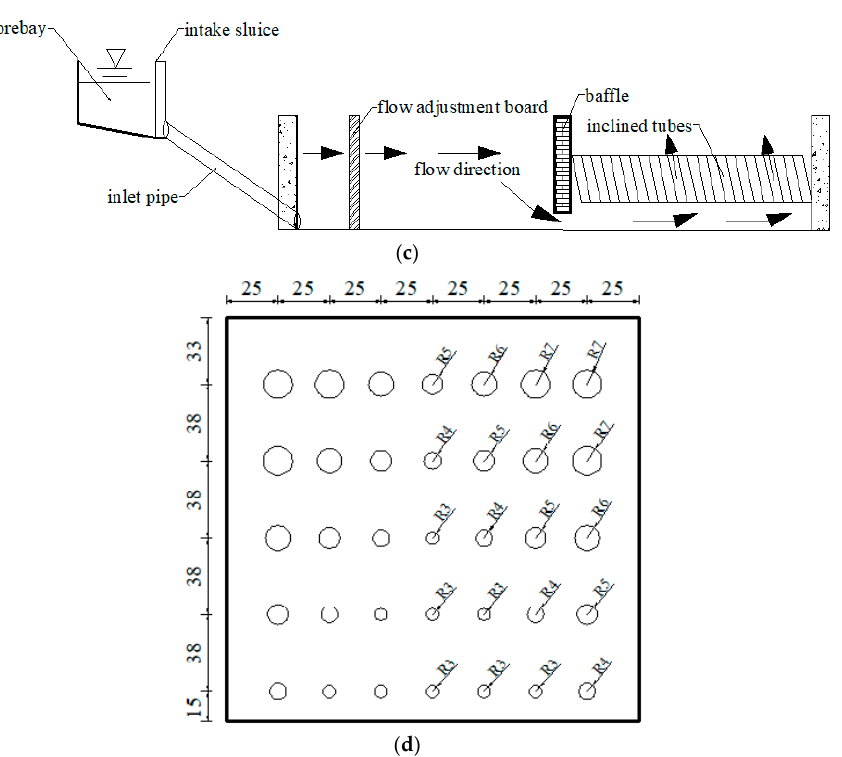
Figure 1. Schematic diagram of the inclined-tube settling tank: ( a ) vertical view of the inclined-tube settling tank; ( b ) cross-sectional view of the inclined-tube settling tank; ( c ) working process of the inclined-tube settling tank; and ( d ) schematic diagram of the flow adjustment board (all the dimensions are in centimeters).